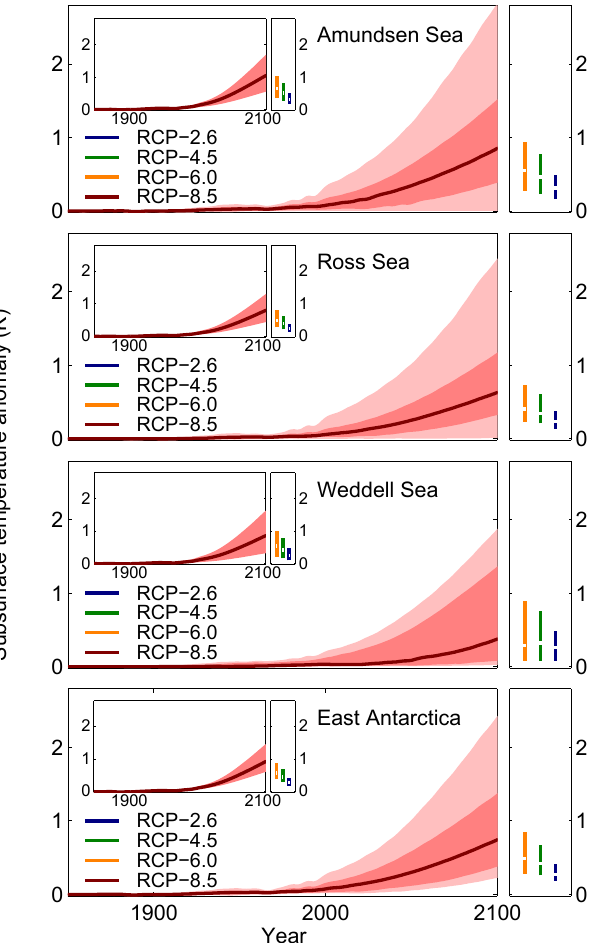
Figure 4. Oceanic subsurface-temperature anomalies outside the ice-shelf cavities as obtained from scaling the range of global mean temperature changes under the different RCP scenarios to the oceanic subsurface outside the ice-shelf cavities. For the downscal- ing, the oceanic temperatures were diagnosed off the shore of the ice-shelf cavities within the four regions defined in Fig. 2 at the depth of the mean ice-shelf thickness as defined in Table 1. These temperature anomalies were plotted against the global mean tem- perature increase for each of the 19 CMIP-5 climate models used here. The best scaling was obtained when using a time delay be- tween global mean temperature and oceanic subsurface temperature anomalies. The scaling coefficients with the respective time delay are provided in Tables 2–5. The thick red line corresponds to the median temperature evolution. The dark shading corresponds to the 66% percentile around the median (red). The light shading corre- sponds to the 90% percentile. Inlays show the temperature anoma- lies without time delay.